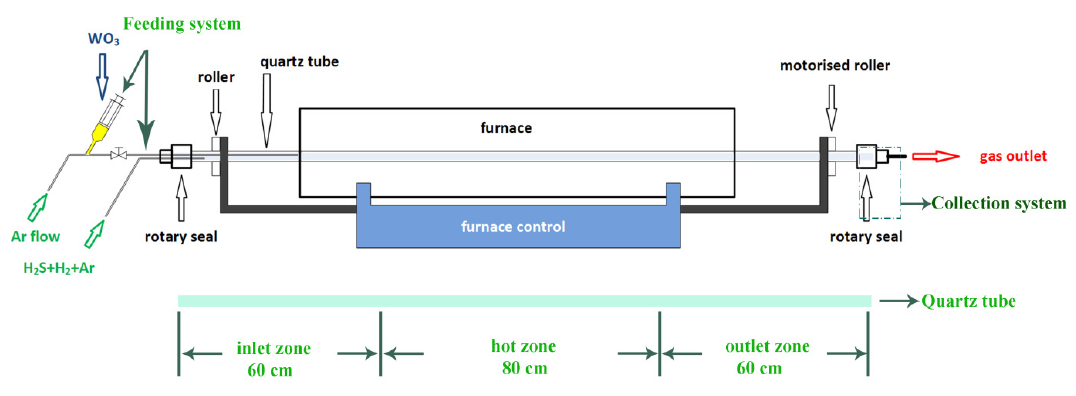
Figure 1. Sketch of the rotary furnace. In a traditional static furnace, the WO still in the quartz tube at high temperature (800–900 °C), which leads to the dominance of in the final products; whilst in the present furnace, the quartz working tubes are 2H-WS 2 and formed WS nanoparticles to rotate and move during the rotating, forcing the WO 3 2 products at minimal process, resulting in better separated IF-WS 2